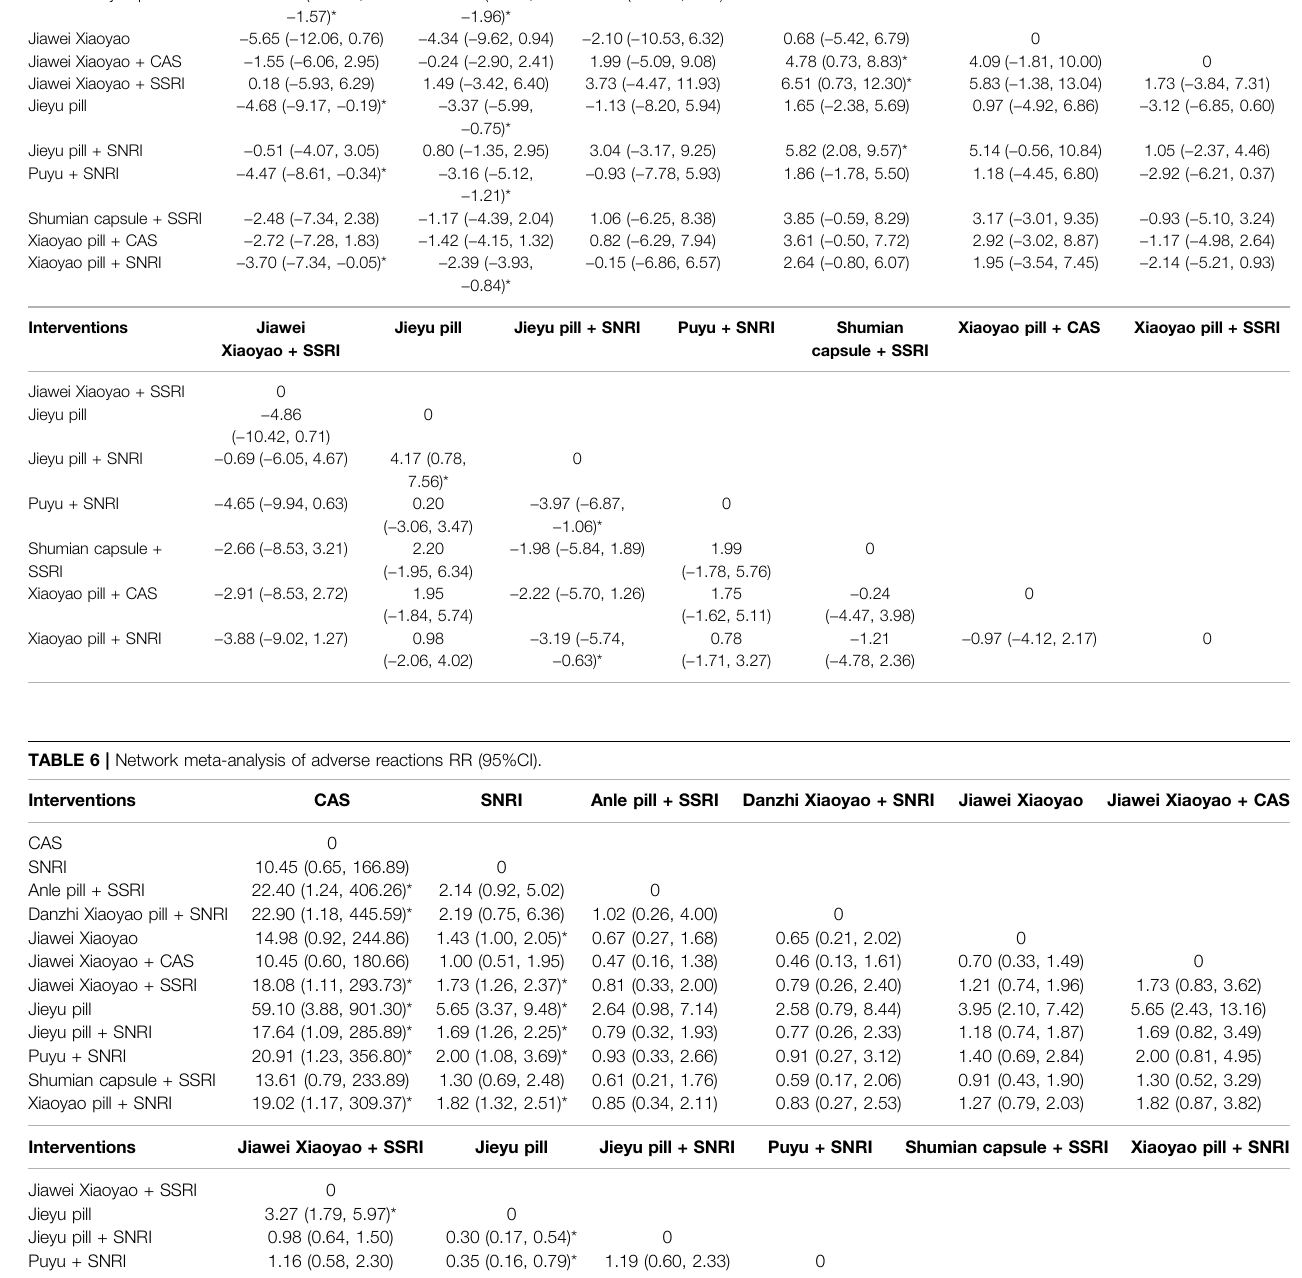
SSRI [RR = 0.23, 95%CI (0.10, 0.53)] and Xiaoyao pill + SNRI [RR = 0.32, 95%CI (0.17, 0.59)]. The other pairwise comparisons showed no statistical signi fi cance ( Table 6 ).